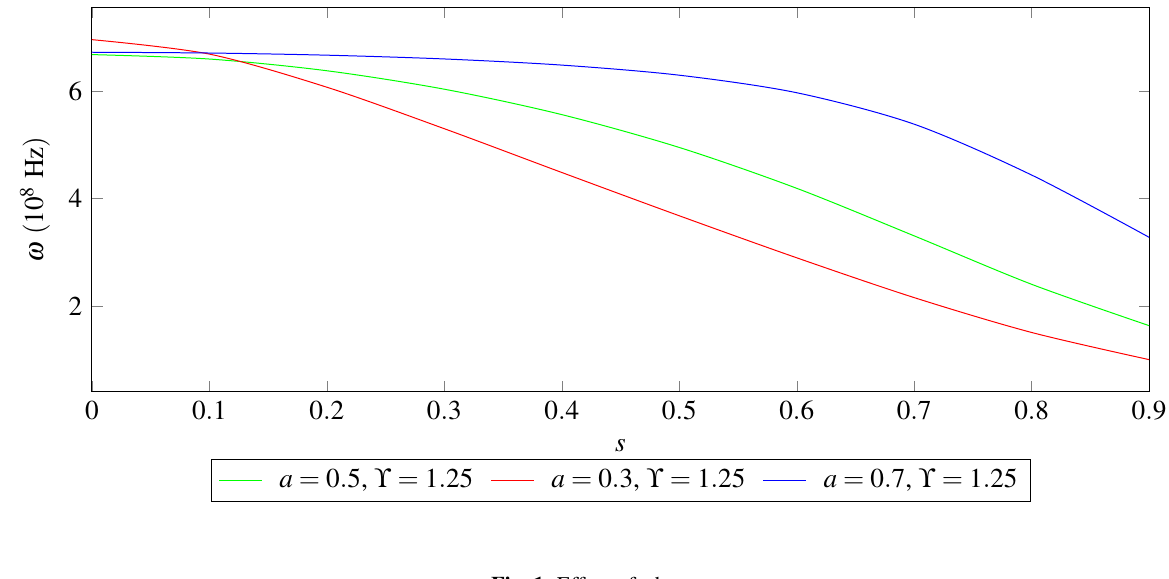
Fig. 1. Effect of s by a .